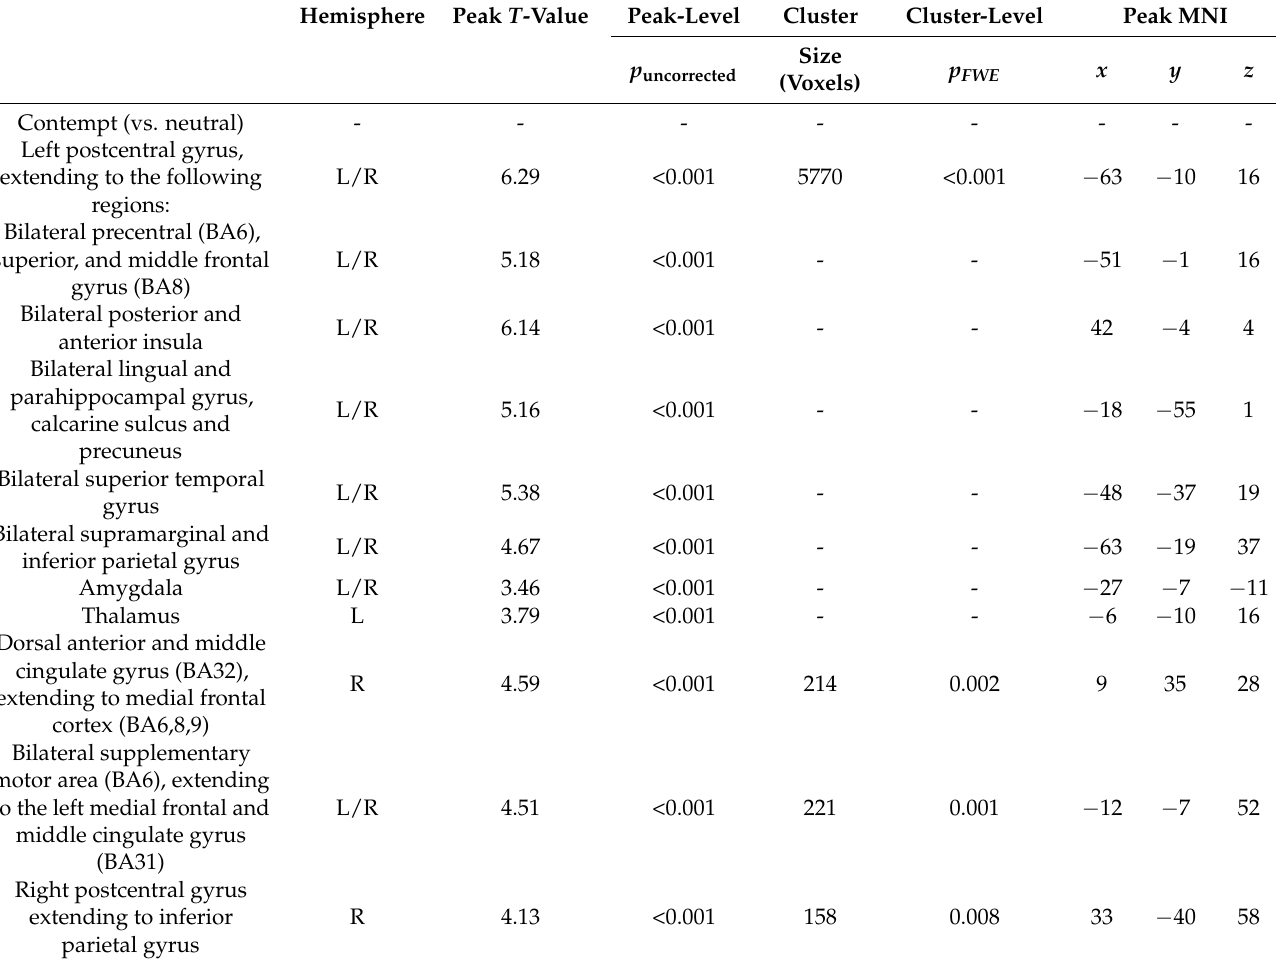
Table 3. Brain regions showing a negative correlation with cognitive avoidant coping style in response to threatening faces under high perceptual